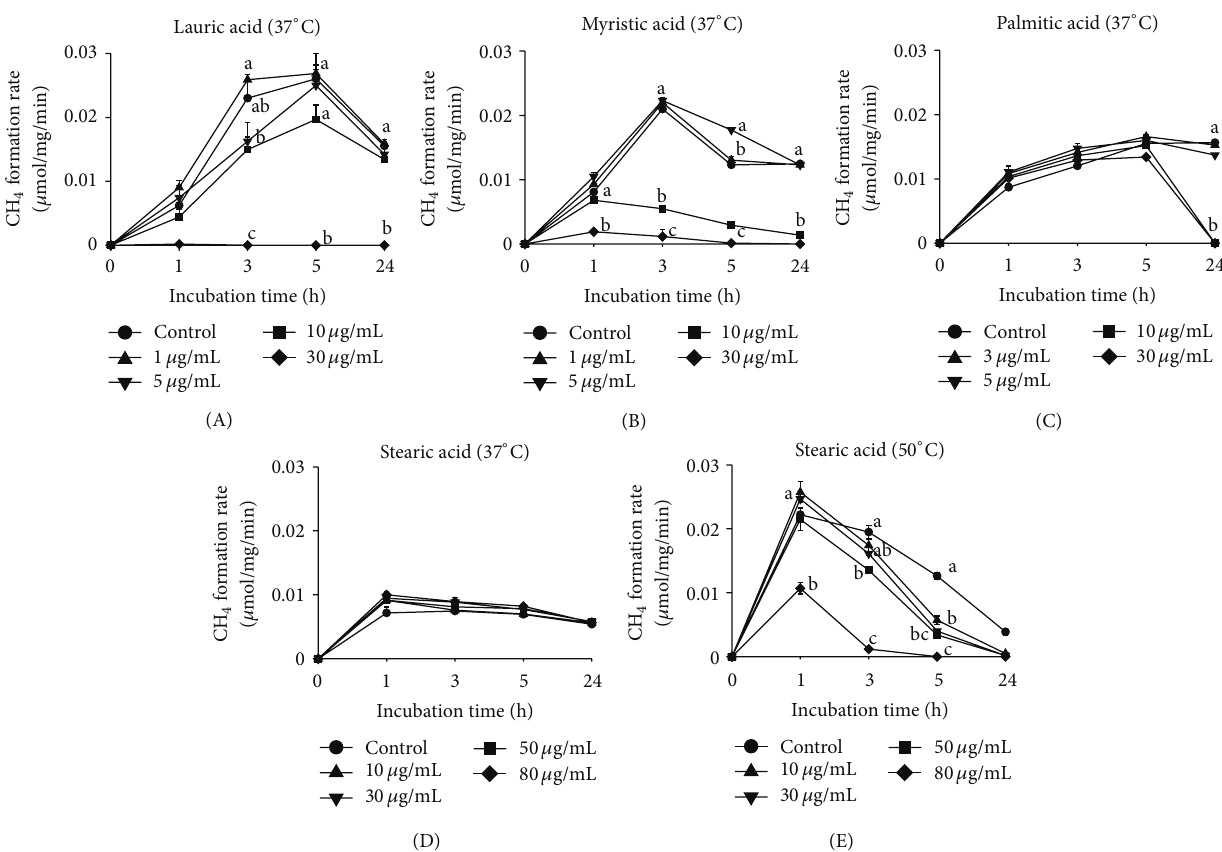
Figure 1: Methane production rate ( 𝜇 mol/mg cell DM/min) in cell suspensions of M. ruminantium in K + -containing buffer ( 𝑛 = 3 ) in response to supplementation of different concentrations of lauric acid (A), myristic acid (B), palmitic acid (C), and stearic acid (D) at 37 ∘ C and of stearic acid at 50 ∘ C (E) (Experiment 1). Means within time point with unequal letters (a, b) are different at 𝑃 < 0.05 . Bars represent standard errors. Table 1: Methane inhibition rate, K + efflux, and cell viability in cell suspensions treated with C ( 𝑛 = 3 ; means ± standard